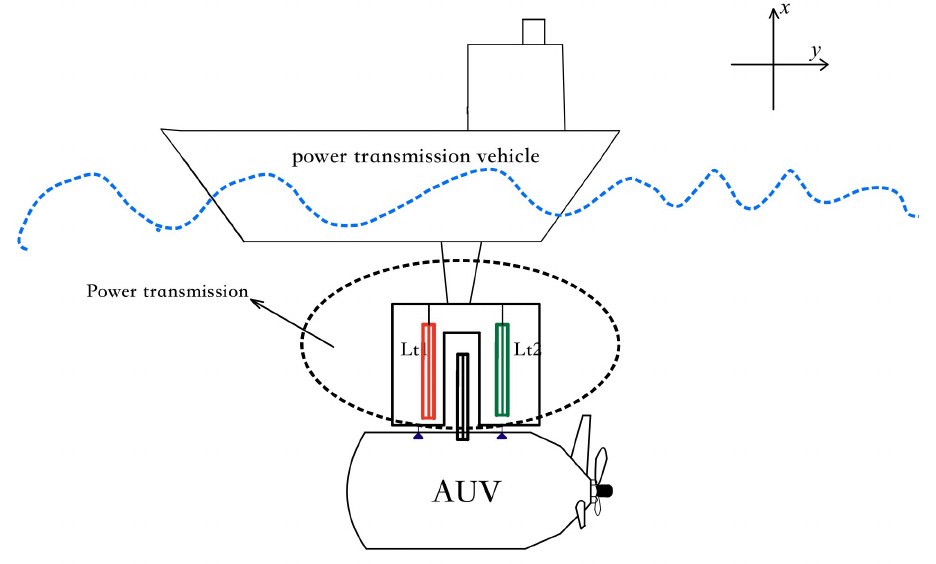
Figure 7. Conceptual diagram of the proposed construction